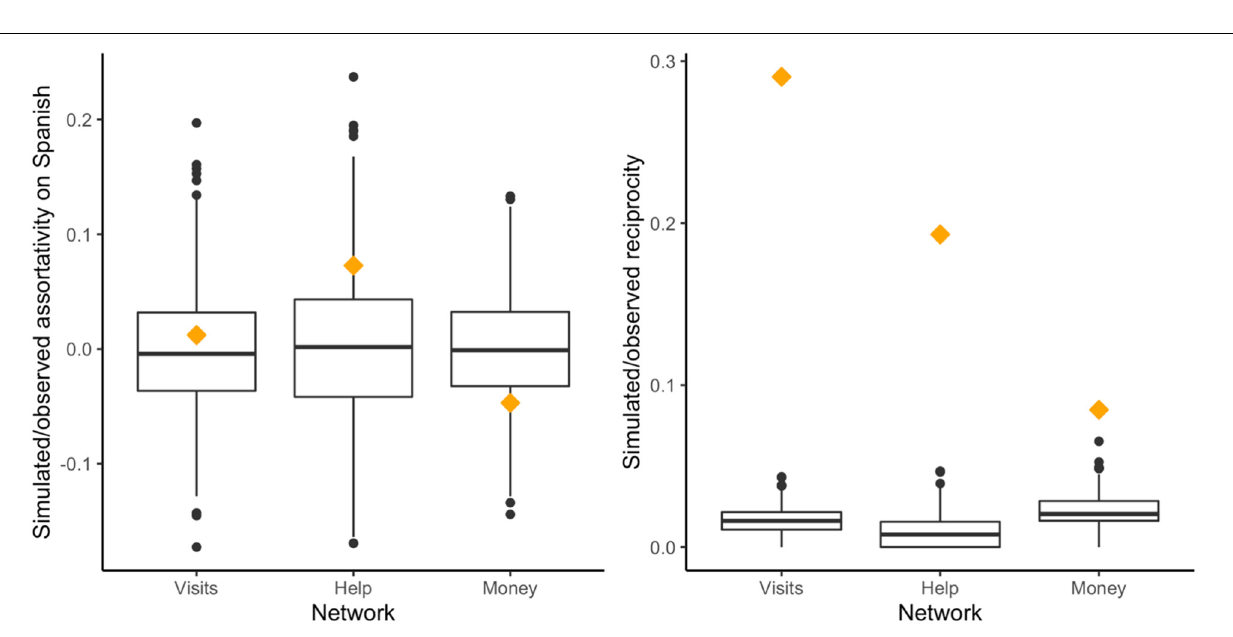
Frontiers in Psychology |